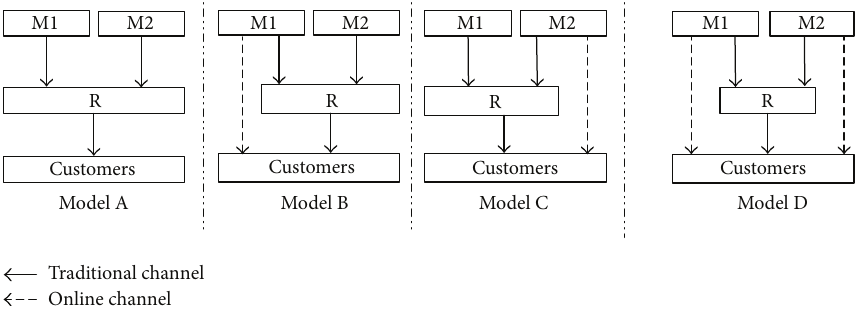
Figure 1: Supply chain structures in online channels and retail